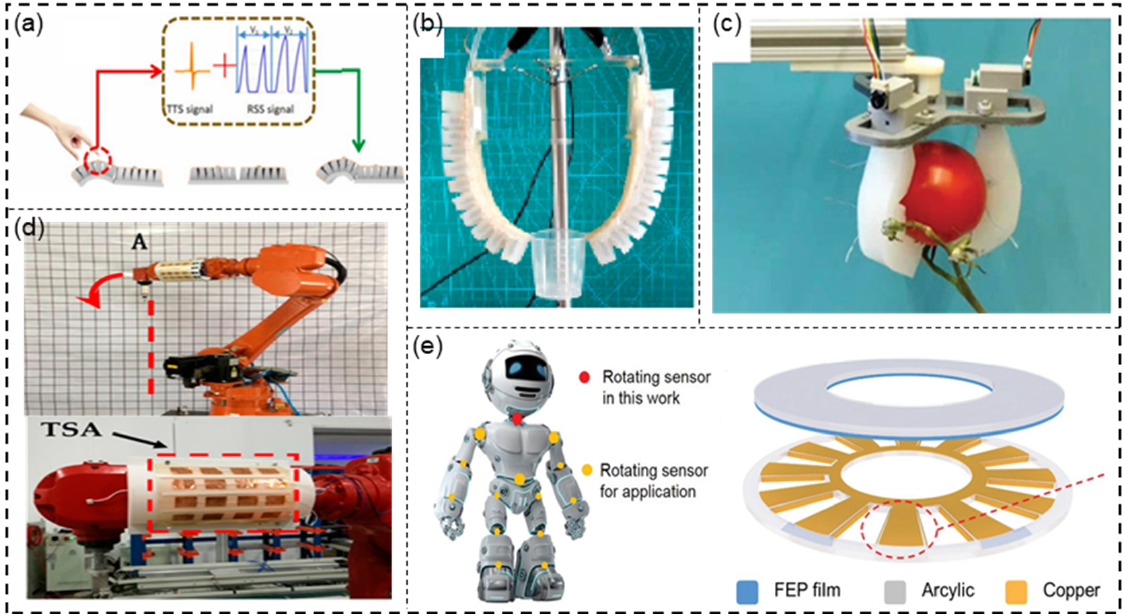
Figure 12. Robot applications. ( a ) Photograph of SCR. Reprinted with permission from Ref. [152]. Copyright 2021 Elsevier. ( b ) Photograph of PSA holding a small cup. Reprinted with permission from Ref. [153]. Copyright 2020 Elsevier. ( c ) Photograph of soft actuator picking tomato from its stem. Reprinted with permission from Ref. [154]. Copyright 2020 John Wiley and Sons. ( d ) Photograph of TSA system for an industrial robot. Reprinted from Ref. [155]. ( e ) Photograph of TVS for monitoring the rotary motion of a robot. Reprinted with permission from Ref. [156]. Copyright 2020 John Wiley and Sons.